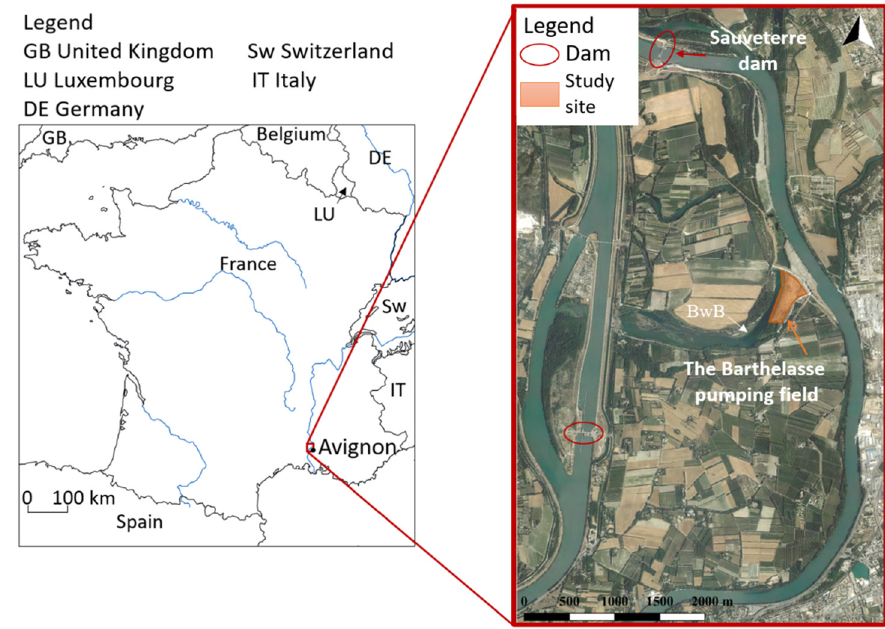
Figure 1. Location of the study area ([29] modified by Poulain A.).